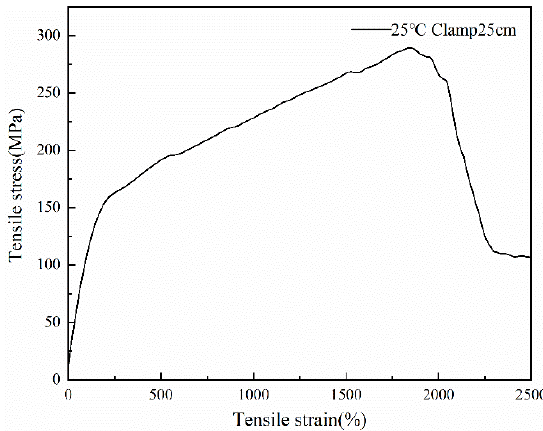
Figure 7. The stress-strain curve at 25 cm clamped at 25 °C.